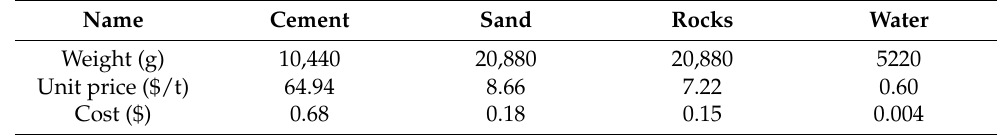
Table 10. Raw materials and costs per square meter of plain